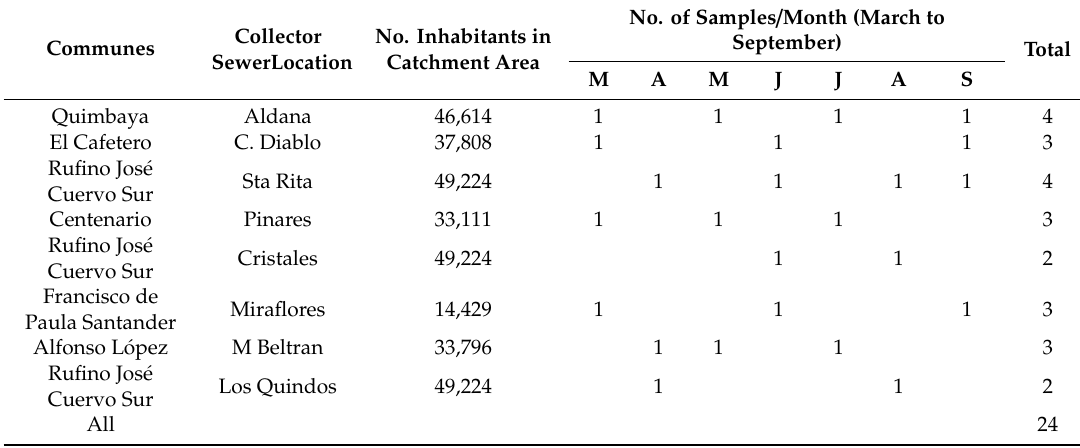
Table 1. Sampling per month for each collector and district during the environmental surveillance in Armenia, Colombia in